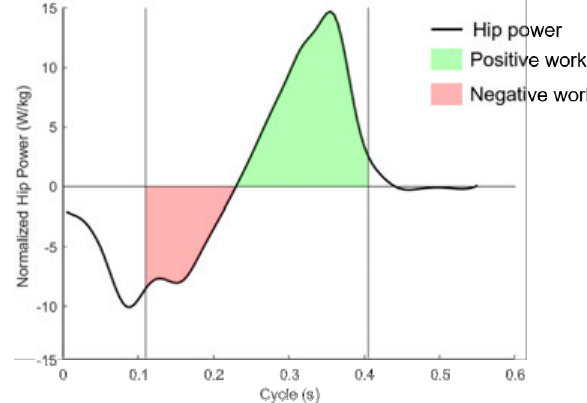
Figure 2 . Example of the time course of the hip joint mechanical power (normalized with participant’s mass) for one trial of one participant. The two vertical lines delimitate the strike phase. Shaded areas represent positive (green) and negative (red)